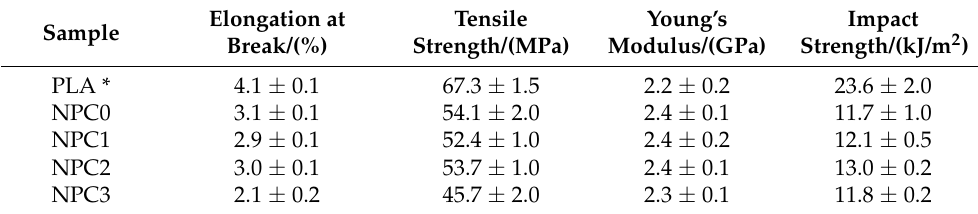
Table 3. Mechanical properties of PLA-OCC NPCs.